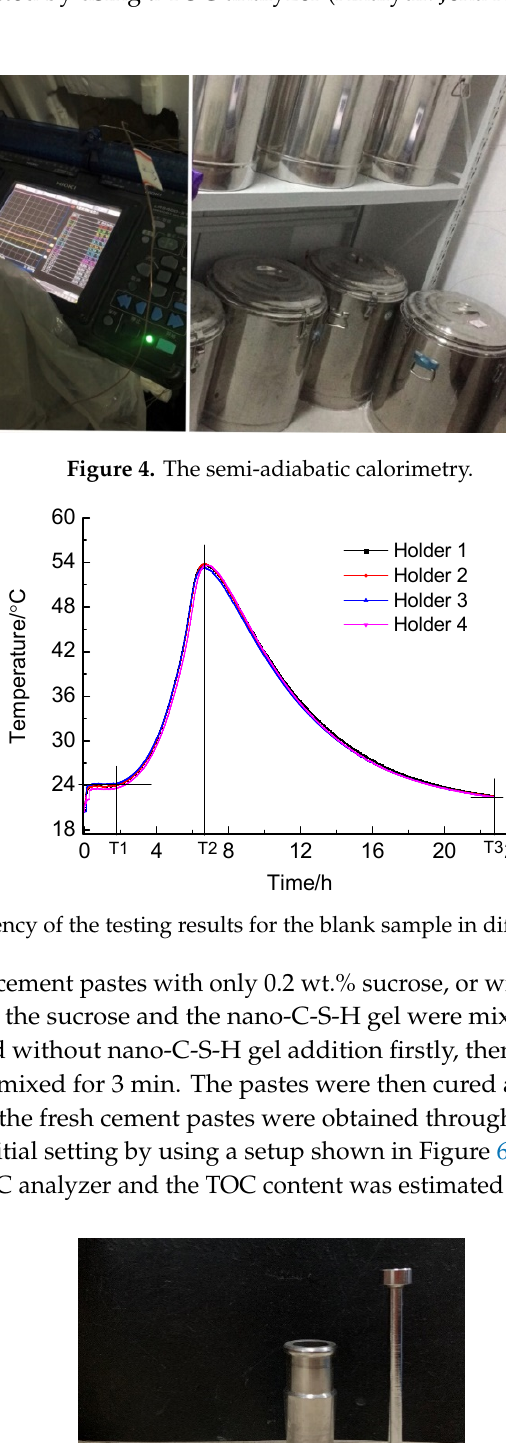
(TOC) testing. carbon (TOC)